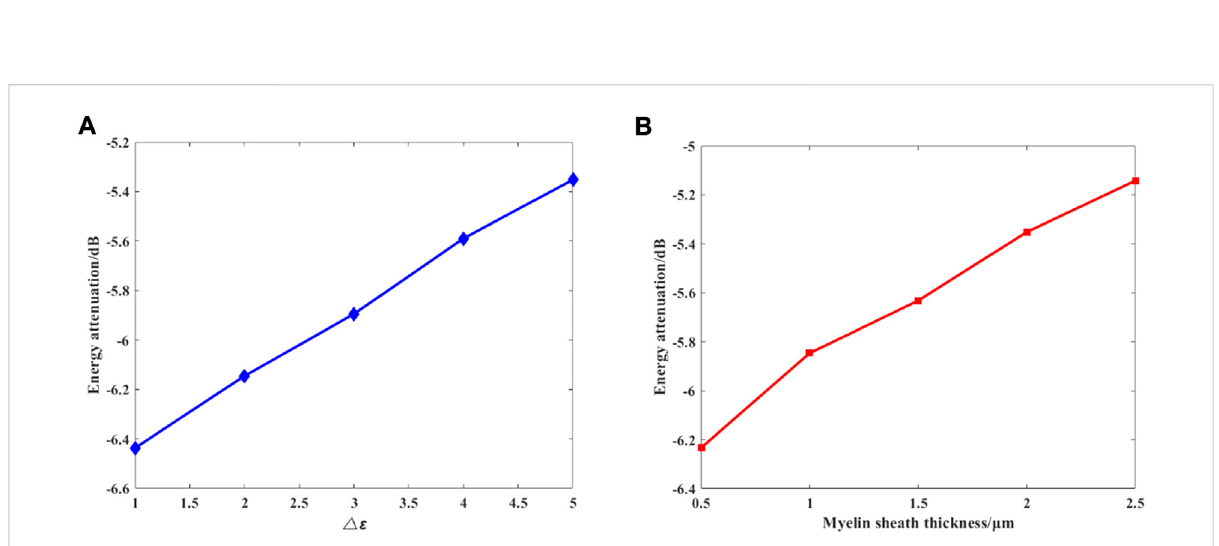
FIGURE 8 (A) Changes in the permittivity of the myelin sheath, and d myelin (cid:1) 2 μ m; (B) changes in the thickness of myelin sheath, and Δ ε (cid:1)